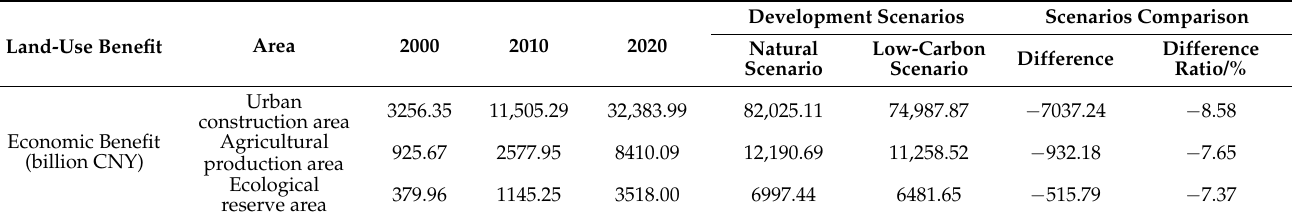
Table 8. Comparison of economic benefits in different development scenarios.